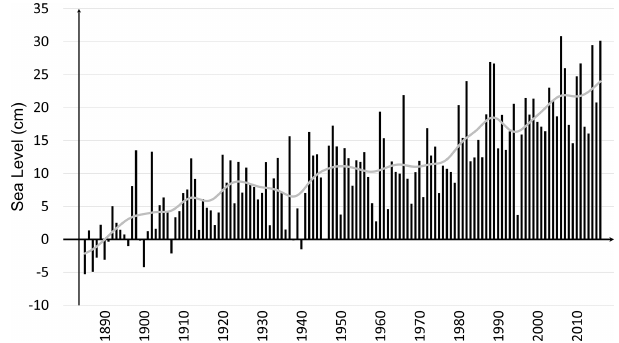
Figure 23. Annual mean sea level changes in centimeters for 14 Swedish mareographs since 1886. The data are corrected for land uplift. The grey line shows a smoothed curve. Data source: https://www.smhi.se (last access: 5 March 2022) at the Swedish Me- teorological and Hydrological Institute, Norrköping, Sweden, com- piled by Berit Recklebe, Leibniz Institute for Baltic Sea Research Warnemünde, Rostock,